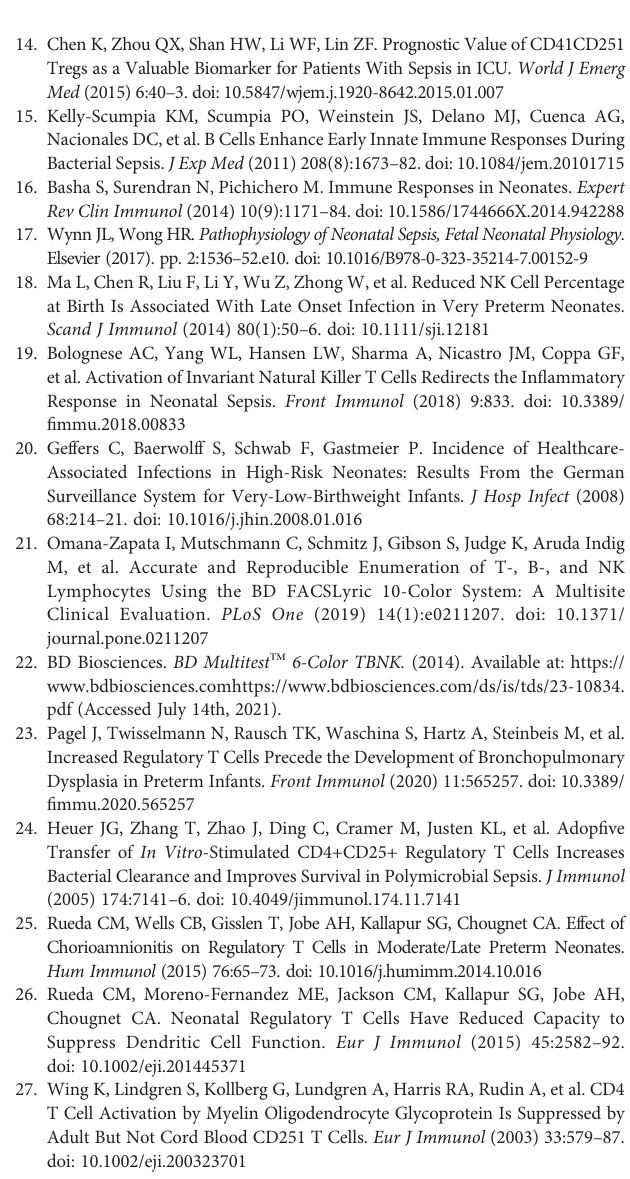
Supplementary Figure 1 | Gating strategy for fl ow cytometry analysis of CD3 + , CD4 + , CD25 + , forkhead box protein 3 (FoxP3 + ) regulatory T cells. Representative plots for the analyses of different lymphocyte subsets via fl ow cytometry (10, 23). CD3+CD4+ cellsweregated, asingle cellgate was setto excludedoublets andthe lymphocytes were determined in the initial steps. Afterwards the lymphocyte gate was backgated on the fi rst population and calculated to a total number of 30.0000 cells in the backgated lymphocyte gate. Total CD3+, CD4+ and CD3+CD4+ cells weredetermined.Thelatterwerefurtheranalyzedandthefollowingsubpopulationswere gated: CD3+CD4+Foxp3+ Tregs, CD3+CD4+Foxp3+ and CD3+CD4+CD25+ cells.